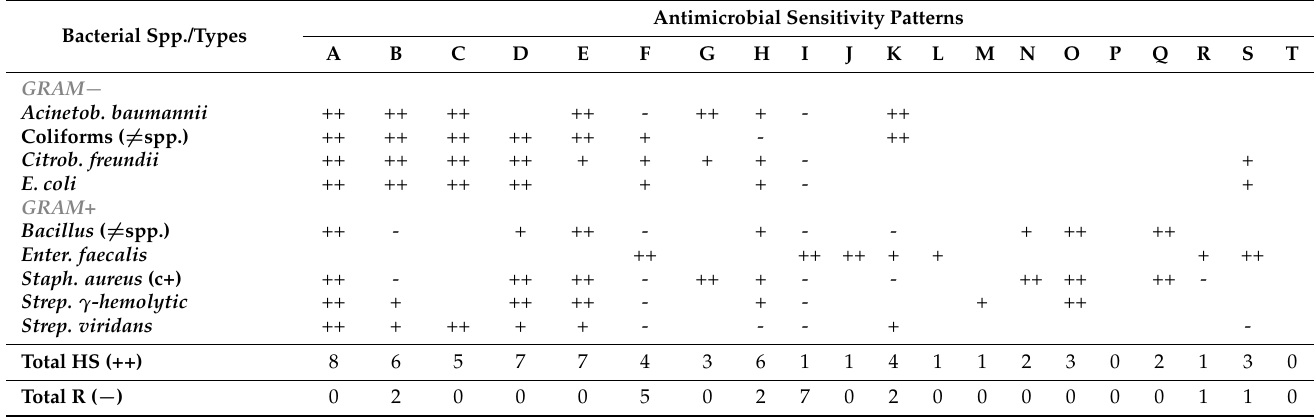
Table 5. Antibiotic sensitivity patterns of the pathogenic isolated bacteria obtained in in vitro cultures derived from intrauterine Cytobrush swab samples in metritis-diagnosed dairy cows naturally infected by E. coli during the early